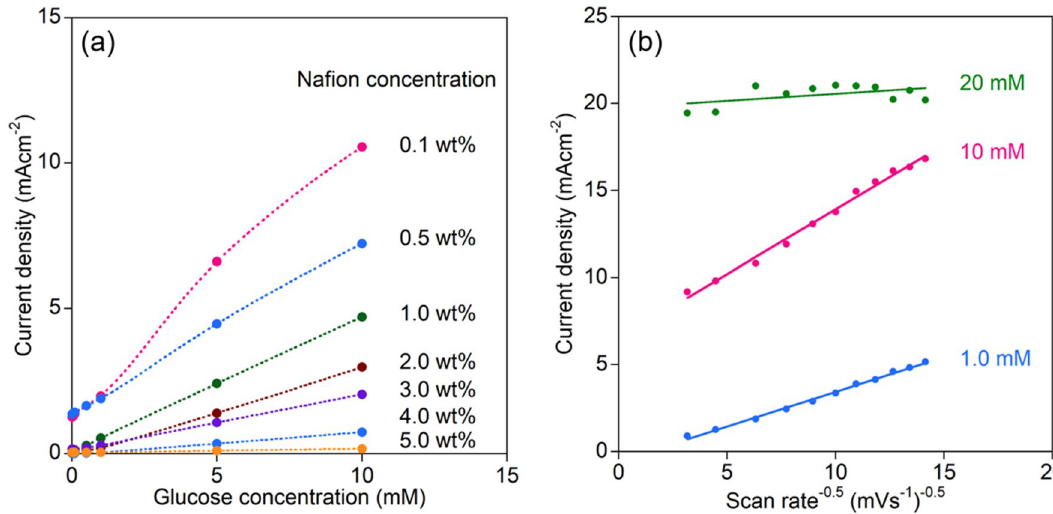
three sensors. b The dependence of the peak current (at 0.5 V (vs. Ag/AgCl)) on the square root of the scan rate with different glucose concentrations. The curve is an average of three trials in every three